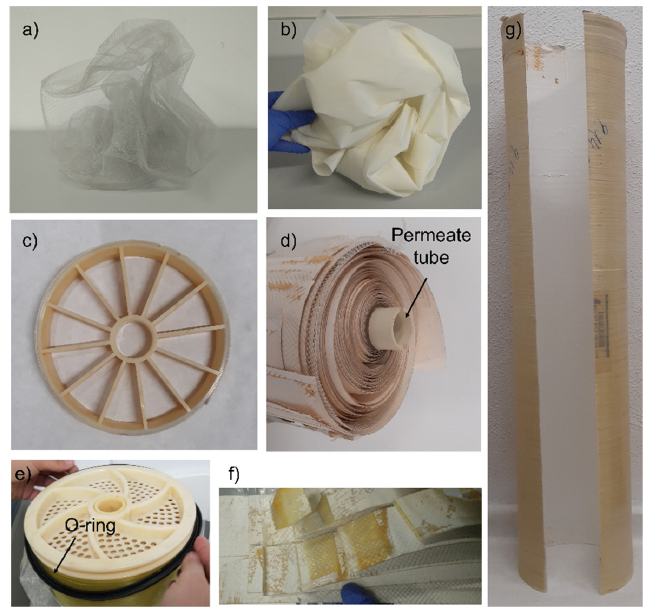
Figure 10. ( a ) PP feed spacer, ( b ) PET permeate spacer, ( c ) ABS end cap, ( d ) ABS permeate tube, ( e ) rubber o-ring, ( f ) glued parts, ( g ) fibreglass